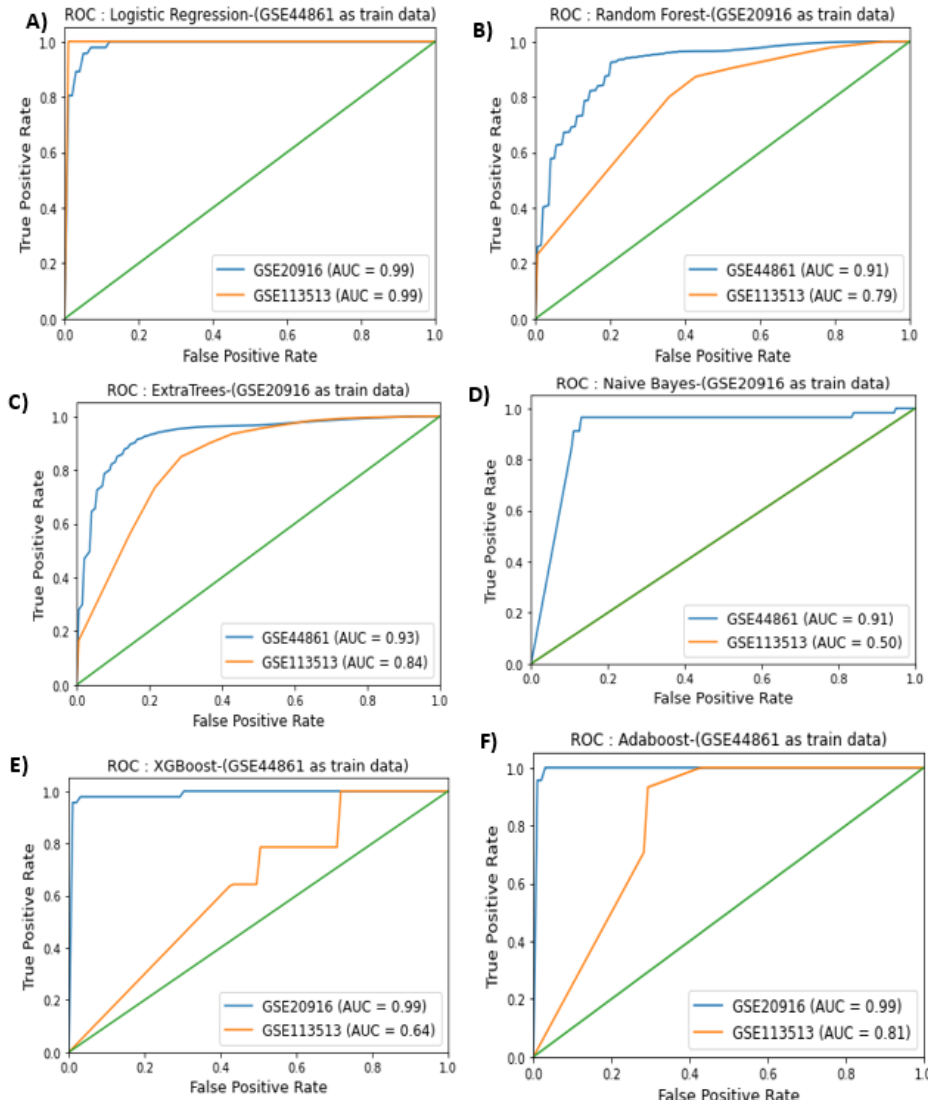
Figure 3. ROC curves for the different classifiers. ( A ) Performance of logistic regression model with GSE44861 as training and GSE20916, GSE113513 as test data; ( B ) performance of random forest model with GSE20916 as training and GSE44861, GSE113513 as test data; ( C ) performance of ExtraTrees model with GSE20916 as training and GSE44861, GSE113513 as test data; ( D ) performance of naïve Bayes model with GSE20916 as training and GSE44861, GSE113513 as test data; ( E ) performance of XGBoost model with GSE44861 as training and GSE20916, GSE113513 as test data; ( F ) performance of Adaboost model with GSE44861 as training and GSE20916, GSE113513 as test data.